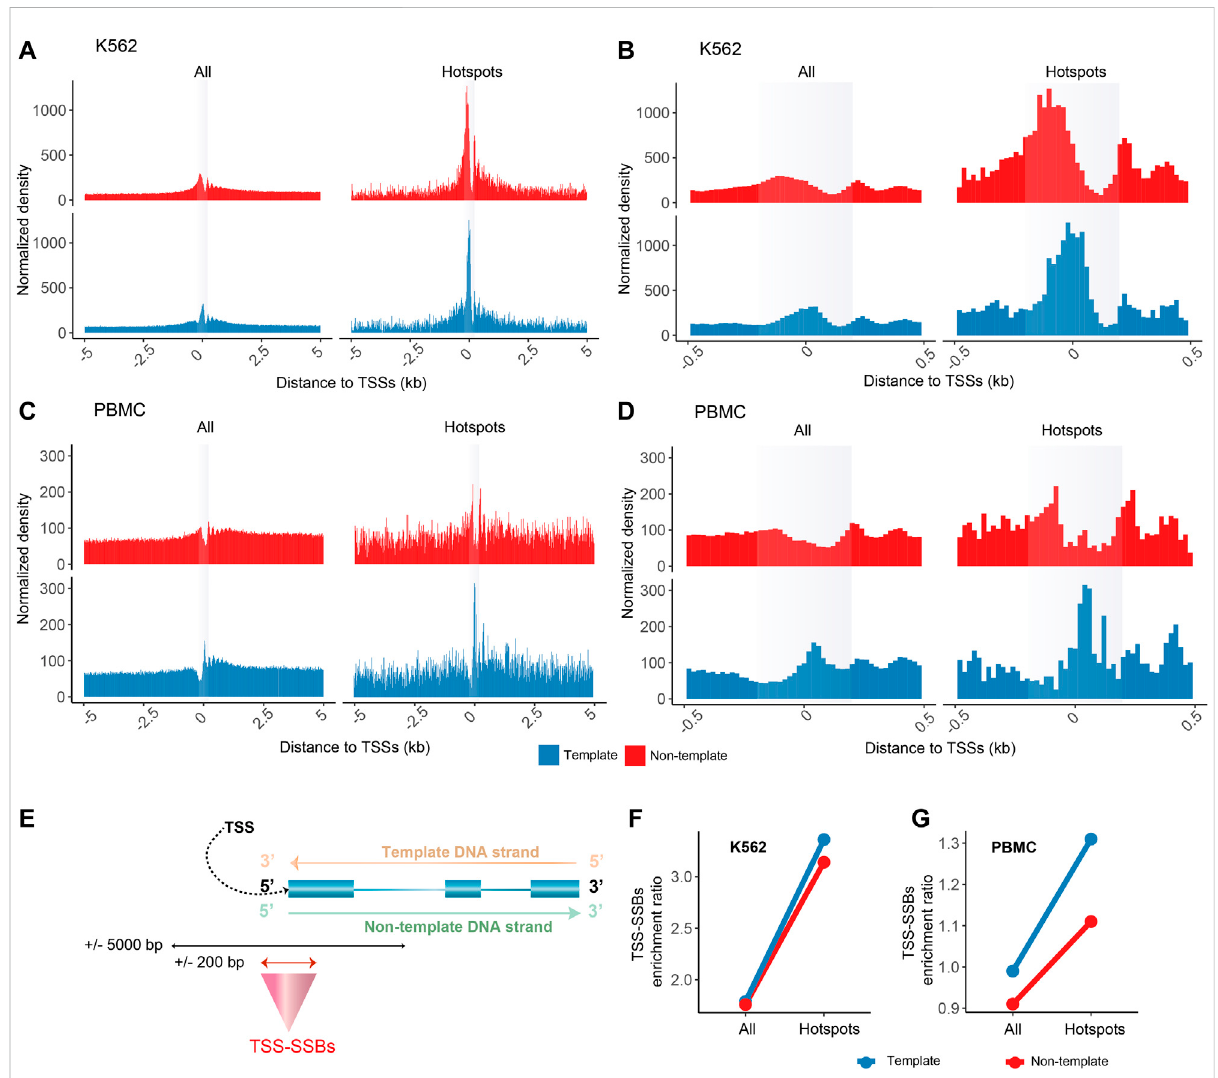
FIGURE 2 Enrichment of SSB hotspots around TSSs. Aggregate plots of the normalized densities (Y-axes) of the positions of all SSBs or hotspots within ±5,000 bp (A,C) or±500 bp (B,D) of the TSSs for K562 (A – B) and PBMCs (C – D) . (A – D) The opaque vertical rectangles represent the±200 bp areas around the TSSs. The aggregate plots for the template and non-template strands of genes are shown separately as illustrated in (E) . (F – G) The TSS-SSBs enrichment ratios (Y-axes) for all breaks and hotspots on either template or non-template strands for K562 (F) and PBMC (G)